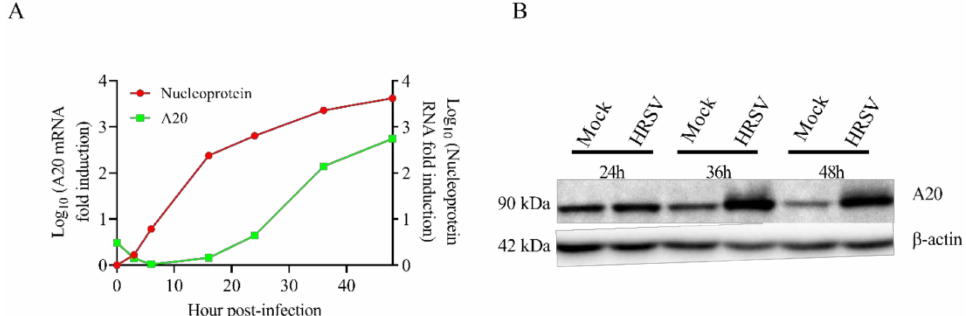
Figure 1. Human respiratory syncytial virus (HRSV) infection of A549 cells enhances A20 expression. A549 cells were infected with HRSV at a multiplicity of infection (MOI) of 3 and harvested at the indicated times post-infection. ( A ) HRSV nucleoprotein and A20 RNAs were quantified by qRT-PCR. The data represent the fold increase of A20 RNA in infected cells compared with mock-infected cells and the fold increase of HRSV nucleoprotein RNA with respect to 0 h post-infection (hpi). RT-qPCRs at each time point were done in triplicate wells. ( B ) Protein accumulation was analyzed by Western blotting using an anti-A20 specific antibody. Normalization was carried out using an anti- β -actin